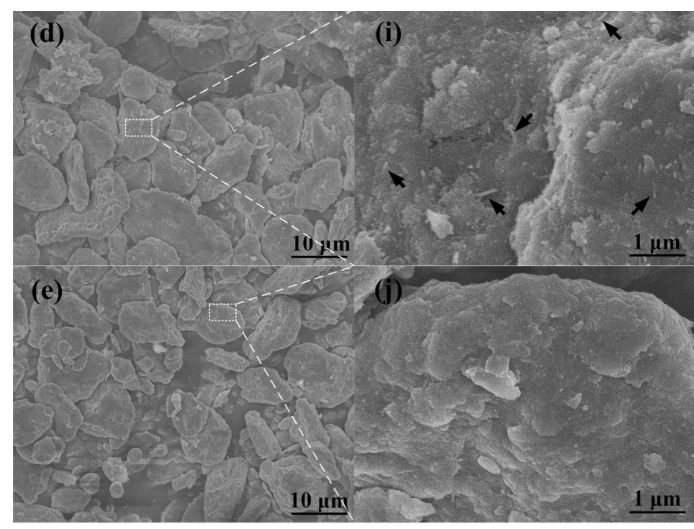
Figure 3. FESEM micrographs of CNT/Al (with powder size of 9 µ m) mixture ball milled for ( a ) 3 h;